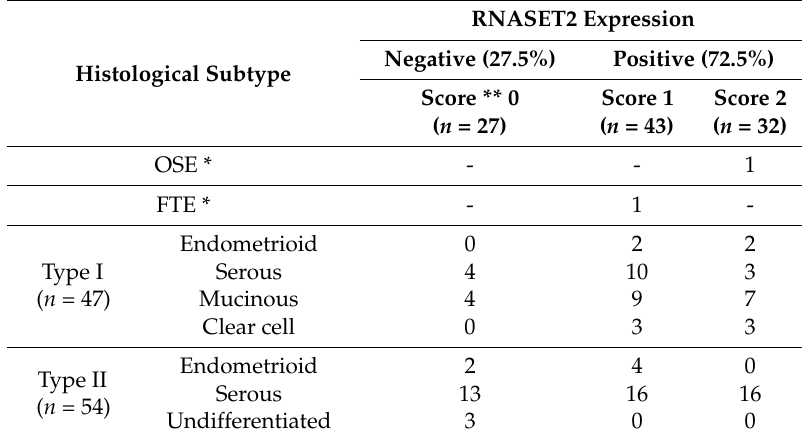
Table 1. Immunohistochemical analysis with anti-RNASET2 Ab on formalin-fixed paraffin-embedded EOC tissue sections.